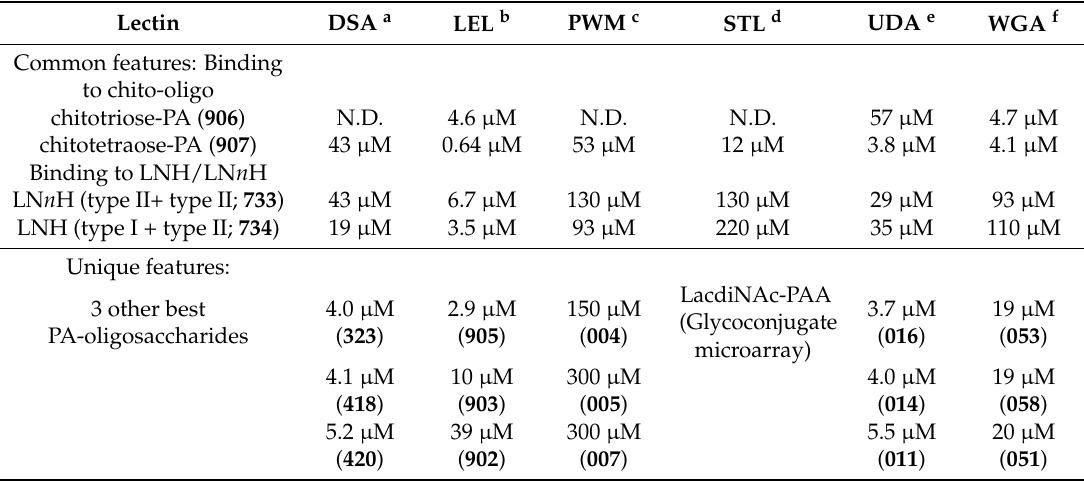
Table 2. Summary of sugar-binding features of the chitin-binding lectins investigated in